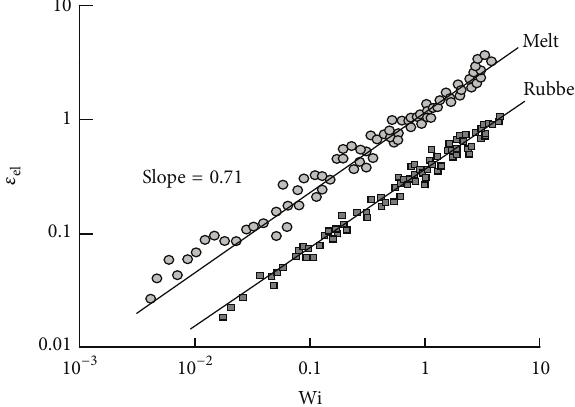
Figure 2: Similarity in dependences of rubbery deformations for linear polyisoprene (melt) and the same sample after slight curing on Weissenberg Number (authors